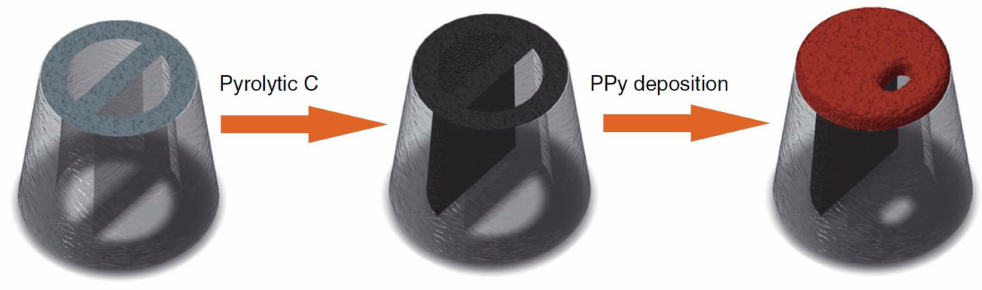
Figure 1. Fabrication of nanopore-extended field-e ff ect transistor (nexFET) in dual-barrel quartz nanopipettes by depositing pyrolytic carbon in one of the barrels before electrodeposition of polypyrrole (PPy) at the carbon-coated nanopipette tip